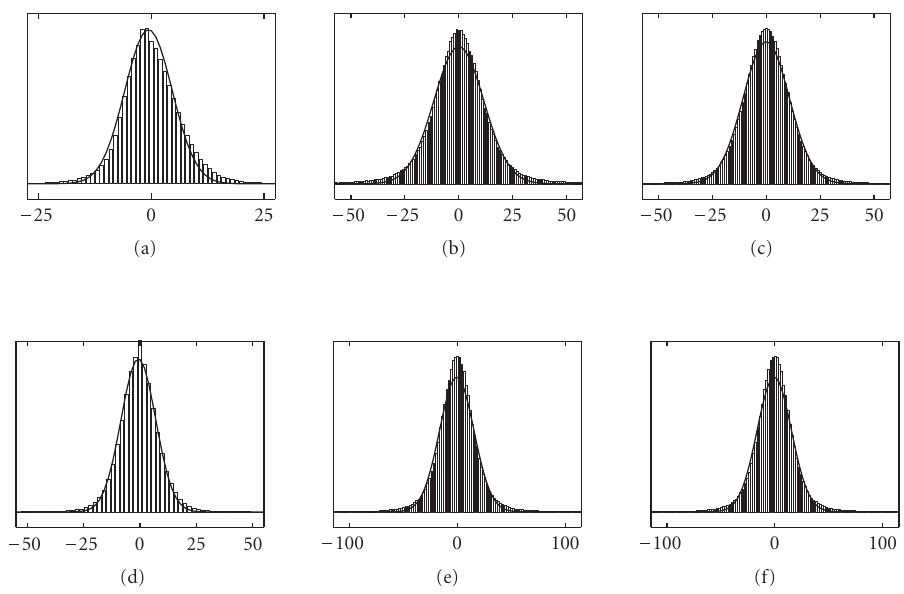
Figure 6: Histograms of three intensity ranges of the images in the time series. Top: time series TS 1 after subtracting the time series mean: (a) low intensity, (b) medium intensity, (c) high intensity. Bottom: time series TS 1 after subtracting the corresponding images of time series TS 2 : (d) low intensity, (e) medium intensity, (f) high